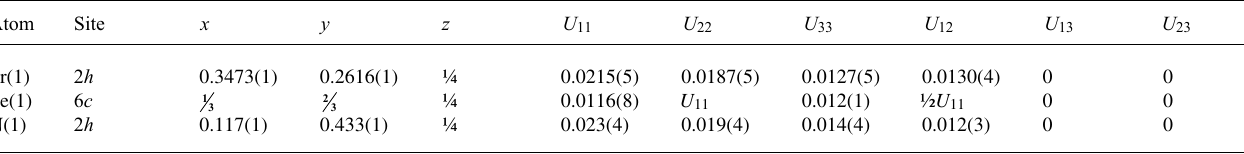
Table 2. Atomic coordinates and displacement parameters (in Å 2 )